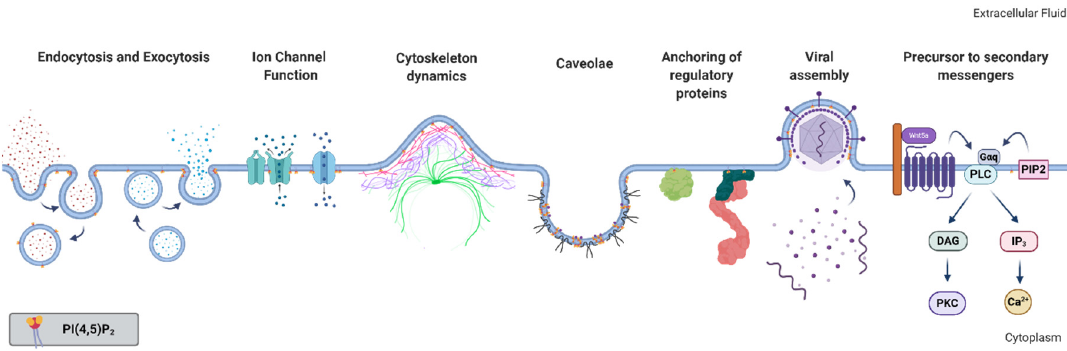
Figure 1. Membrane processes associated with or dependent on phosphatidylinositol 4,5-bisphosphate (PI(4,5)P 2 ). Figure created with BioRender.com.